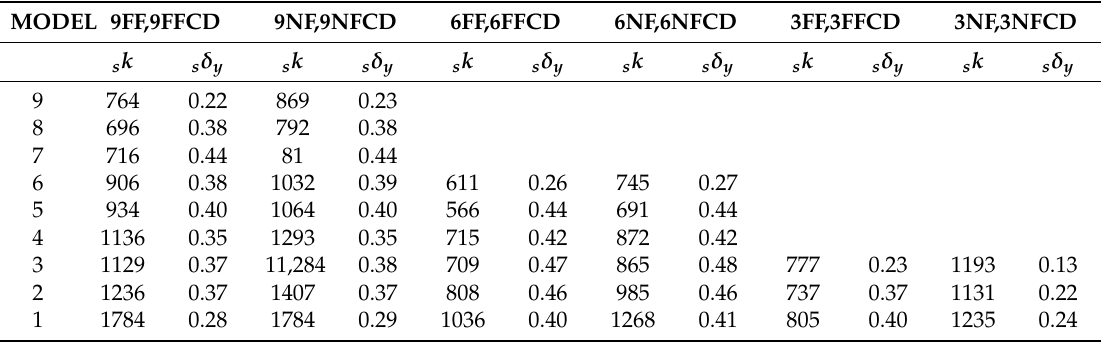
Table 3. Properties of hysteretic dampers at floor level: lateral sti ff ness, yield displacement. MODEL